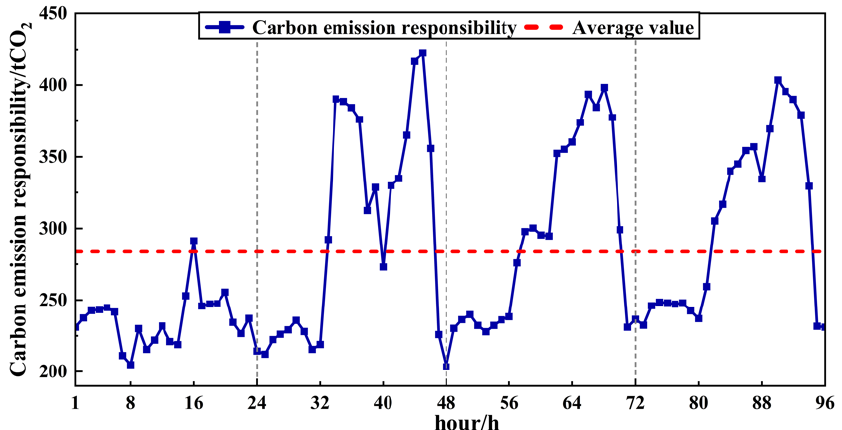
Table 6. The Comparisons of Energy Supply Cost, Subsidy, and Capacity Configuration. Figure 7. Carbon emission responsibility and average value. Figure 7. Carbon emission responsibility and average value.